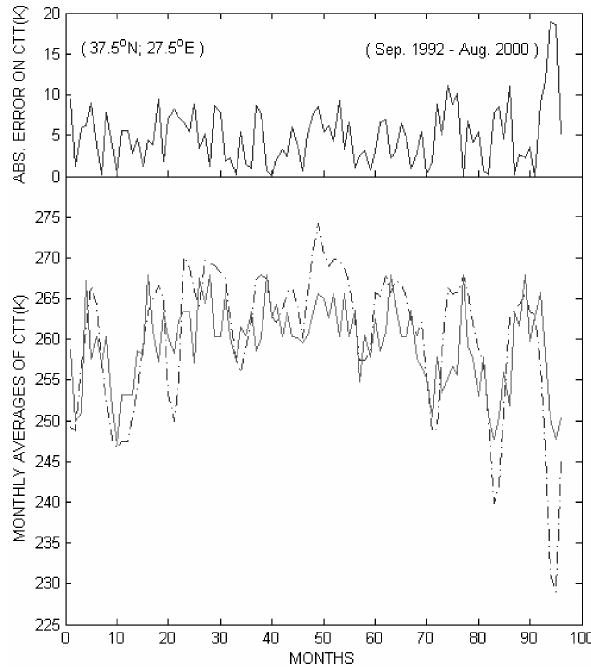
Fig. 7. Observed monthly averages of the CTT values (dashed) and superimposed are the one month in advance forecast CTT values (solid) versus time. The absolute error values on the computed pa- rameters versus time are shown in the top